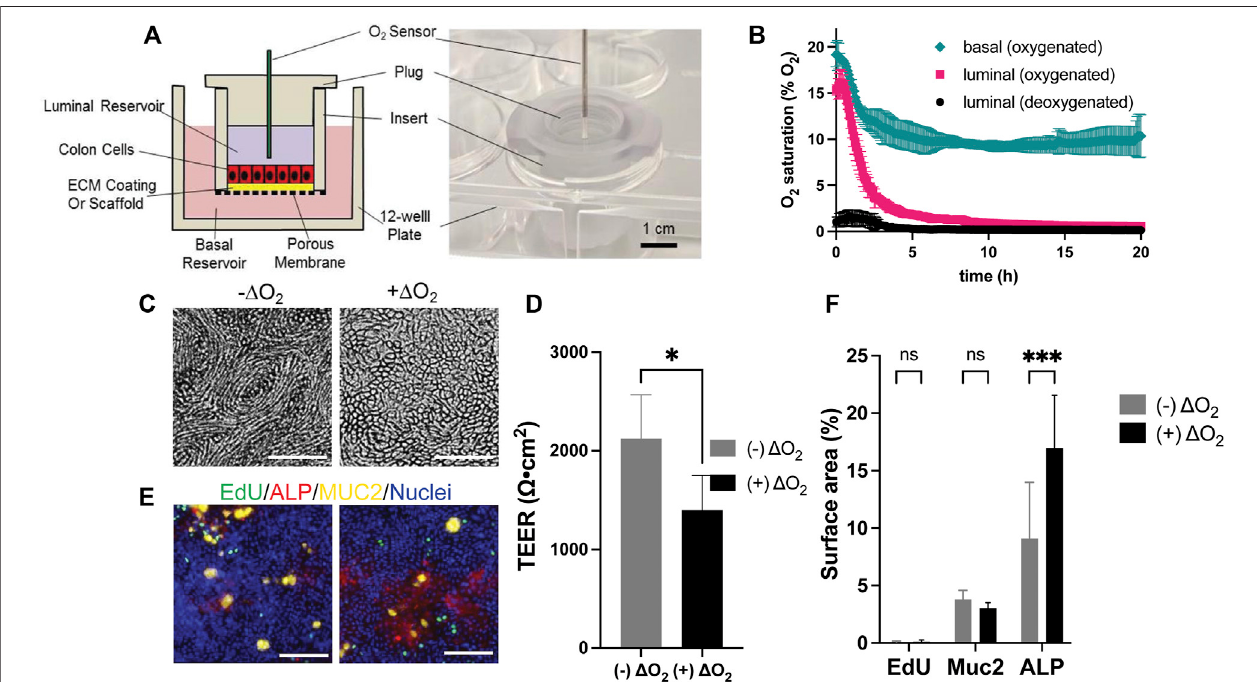
FIGURE 1 | Design and culture of epithelial cells within the O 2 gradient cassette. (A) Shown is a cross-sectional schematic (left panel) and a tilted top-view photograph(rightpanel)ofthecassettewithinsertedluminalO 2 sensor. (B) MeasuredO 2 saturationovertimeintheluminalandbasalreservoirs.Timezerowaswhenthe plug was installed. Shown is the luminal O 2 saturation when deoxygenated (black circle) or oxygenated medium (magenta square) was loaded into the luminal reservoir. In both conditions the basal reservoir received oxygenated medium. Shown also is the O 2 saturation (green diamond) in the basal reservoir when the luminal and basalreservoirsbothreceivedoxygenatedmedia.Thedatapointsrepresenttheaverageofthemeasurements, andtheerrorbars thestandarddeviationofthedata( n = 3 independent cultures). (C) Bright fi eld images of cells with and without an O 2 gradient ( Δ O 2 ). (D) Measured TEER values of the epithelial cells with and without an O 2 gradient (n = 4 technical replicates). (E) Confocal fl uorescence images of the cells with (right) and without (left) an O 2 gradient ( Δ O 2 ). EdU incorporation (green), MUC2 immunostaining (yellow), ALP activity (red), or Hoechst 33,342-stained DNA (blue). Scale bar = 100 µm. (F) The amount of EdU incorporation, MUC2 immunostaining, andALPactivitywasquanti fi edbyplottingthepercentageofthecultureareapositiveforthesestainsdividedbythesurfaceareapositiveforHoechst33342tonormalize for the cell number. The data points represent the average of the measurements, and the error bars are the standard deviation of the technical replicates for n = 4 technical replicates. Unpaired t -test: * p ≤ 0.05; N.S. p >